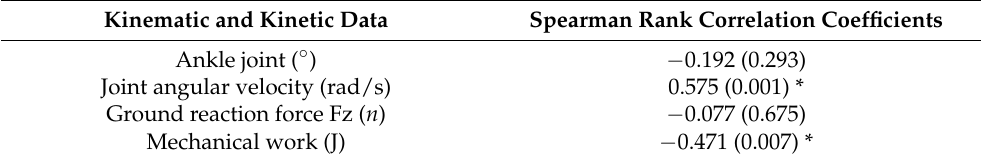
Table 4. Correlations between the kinematic and kinetic characteristics (in the eccentric phase of the one-legged heel-raise exercise) and normalized one-legged hopping